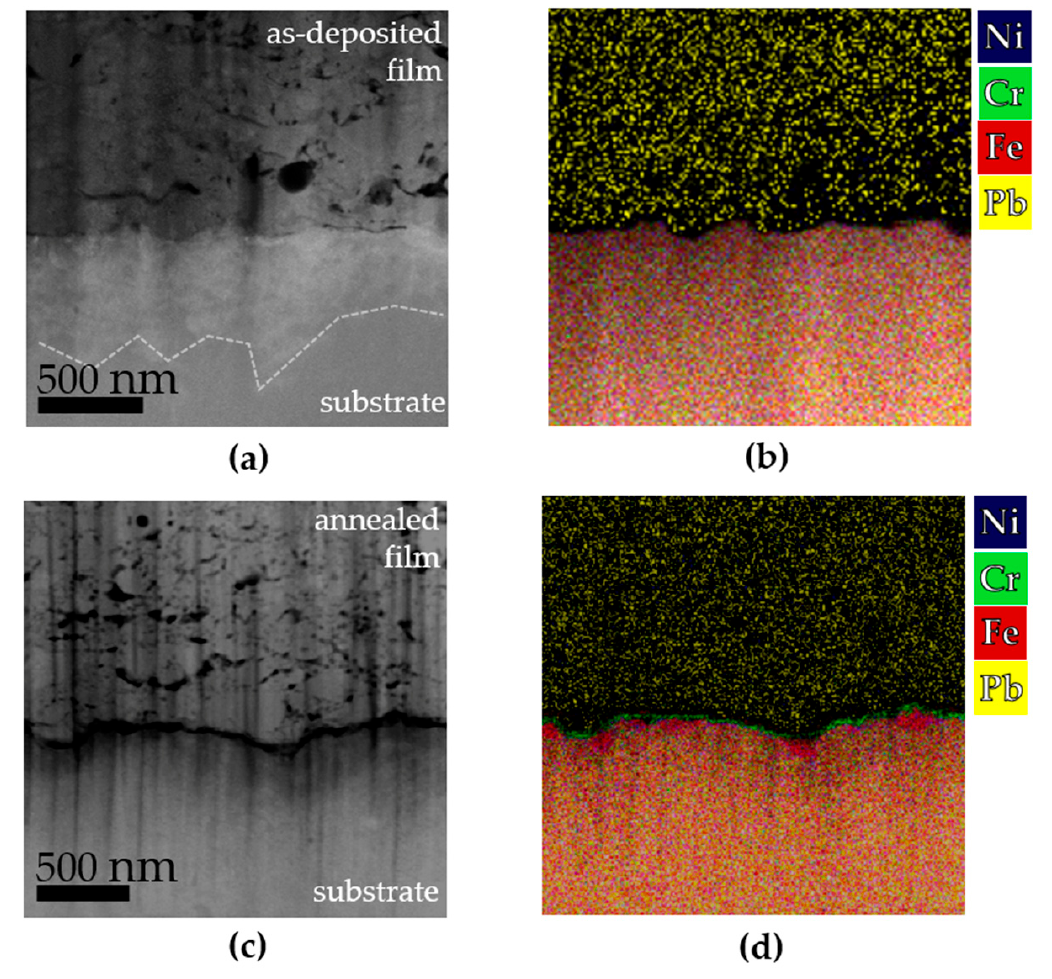
Figure 2. Film-substrate interface in STEM dark-field images and EDS, respectively, of ( a , b ) the as- deposited film and ( c , d ) the annealed film. In ( a ) the dashed line marks the extent of the mechanical deformation observed in the substrate due to particle impact. For the EDS mappings, the spectral lines Ni K, Cr K, Fe K and Pb L were used.